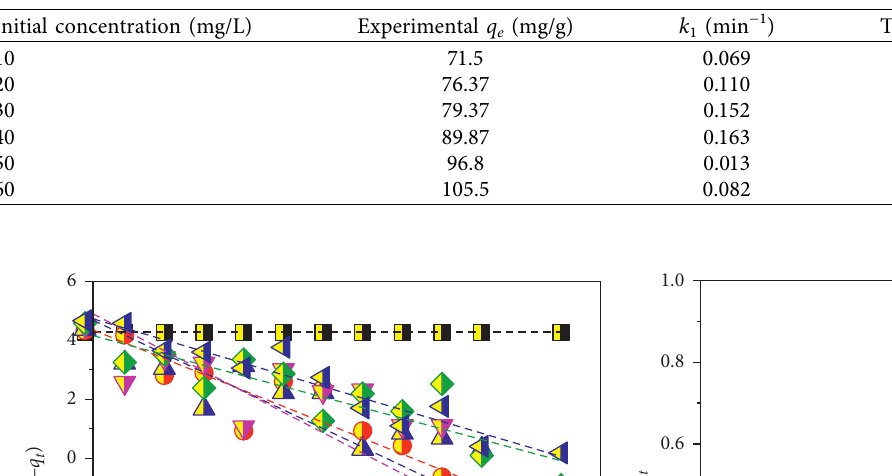
Table 3: Kinetic constants of the pseudo-first-order model.